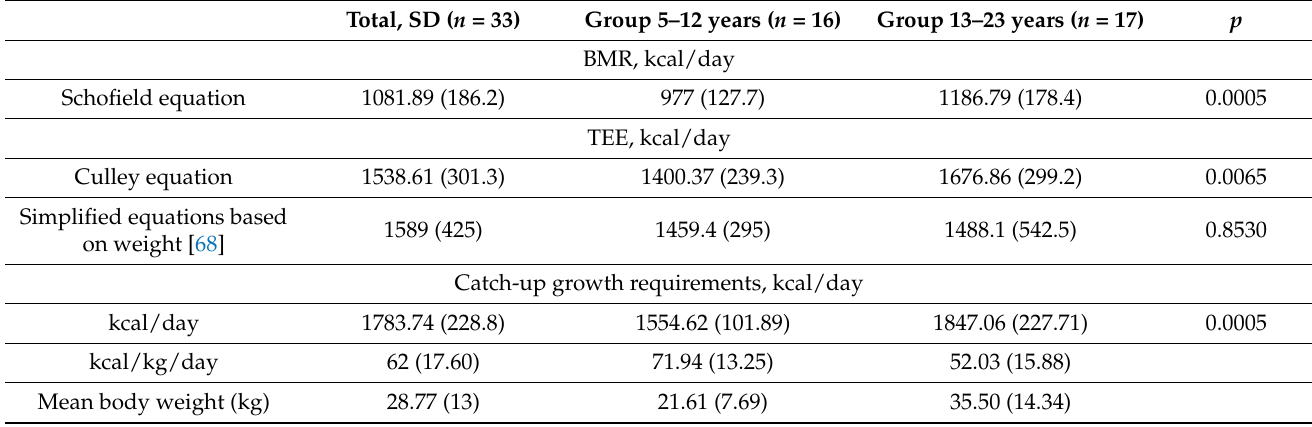
Figure 9. Relationship between student resting energy expenditure (Schofield) and fat-free mass (kg) ( n = 20). Table 6. Description of energy expenditure and energy requirements for growth recovery comparison and comparison by age, mean